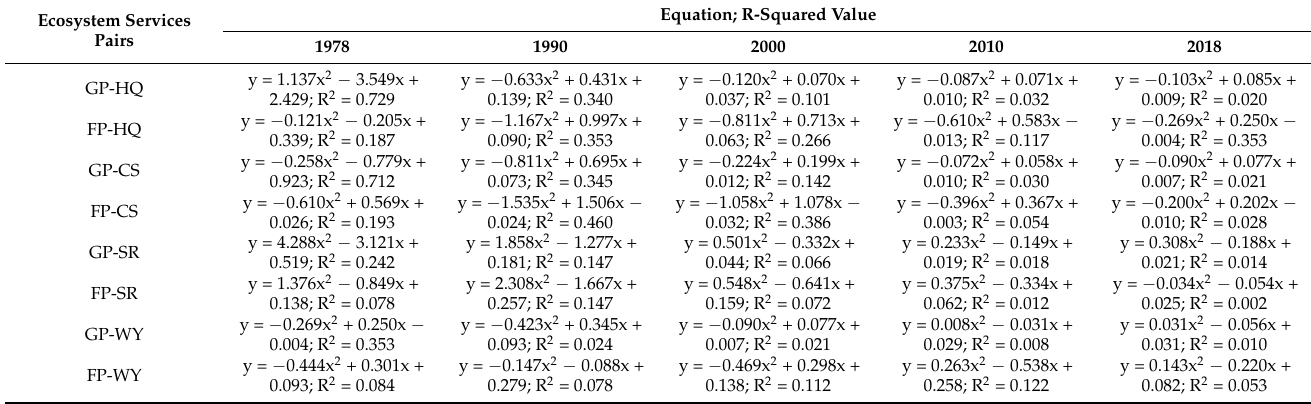
Table A1. Equations of fitted curves for ecosystem services pairs with trade-offs.